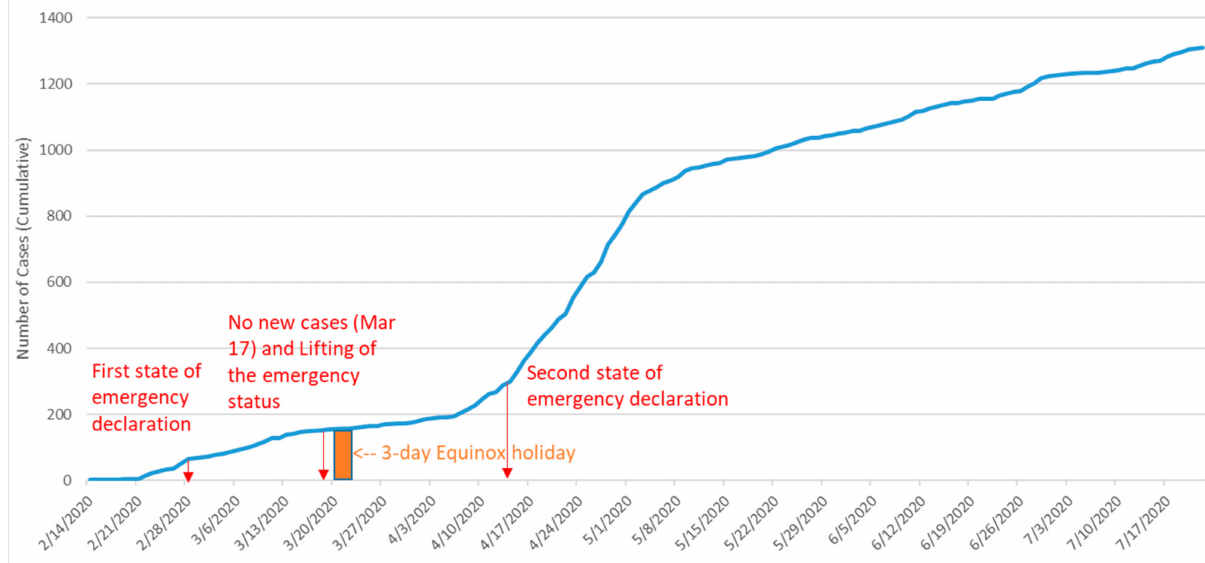
Figure 1. The cumulative cases of COVID-19 patients in Hokkaido (14 February–22 July 2020). Sources: Author generated using the information from the following sources: http://www.pref.hokkaido.lg.jp/hf/kth/kak/hasseijoukyou.htm